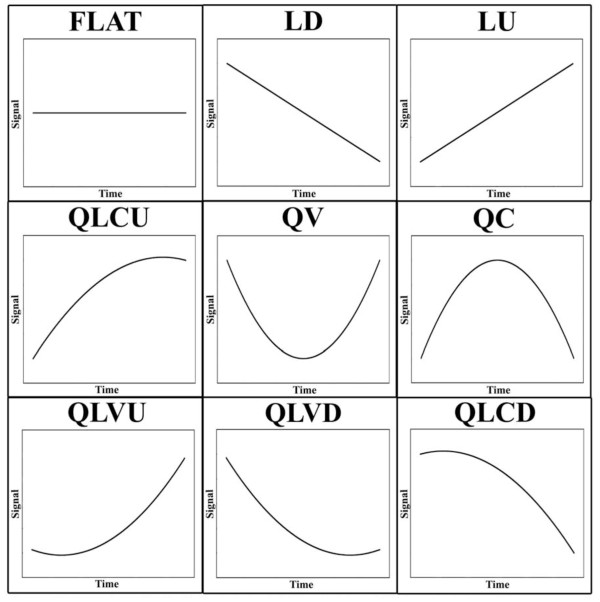
Regression patterns of differentially expressed genes identified from axolotls and tiger salamanders. LD = linear down, QLCD = quadratic linear concave down, QLVD = quadratic linear convex down, QV = quadratic convex, LU = linear up, QLVU = quadratic linear convex up, QLCU = quadratic linear concave up, and QC = quadratic concave.